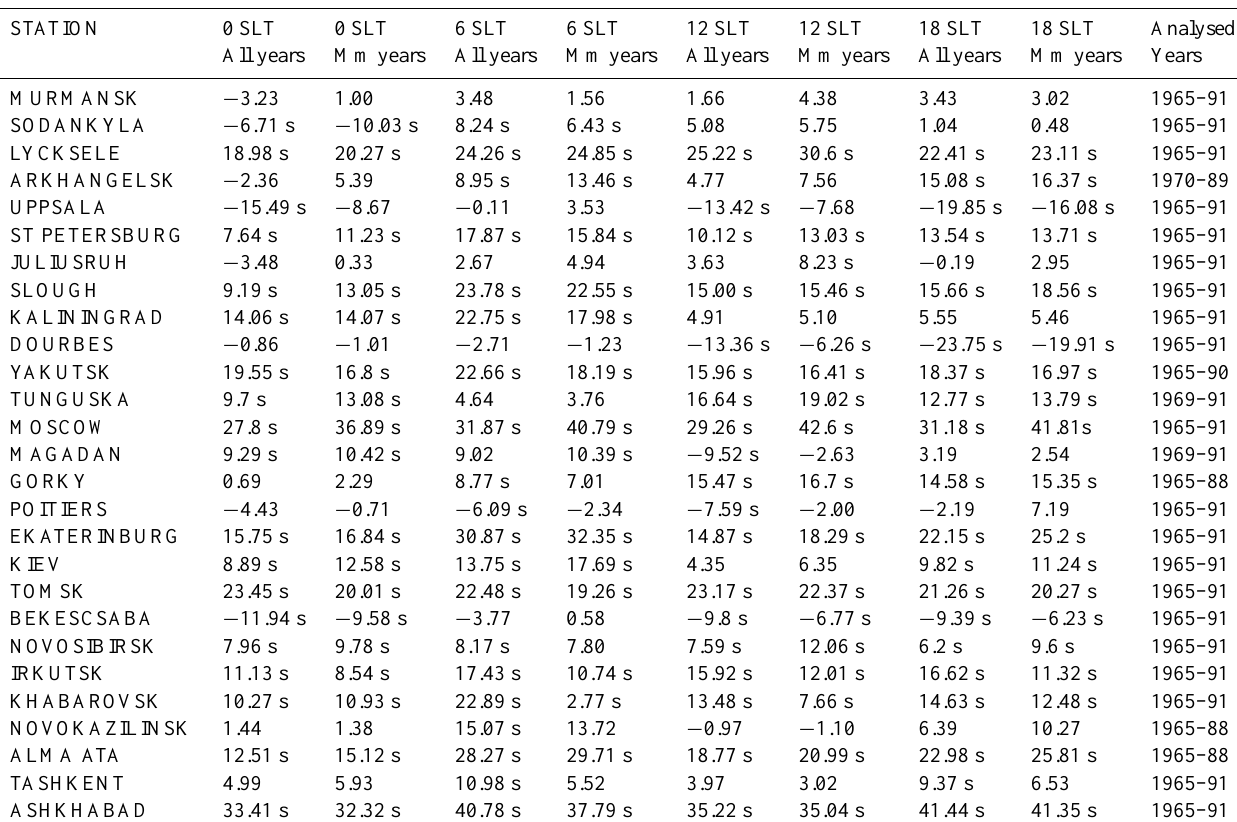
Table 4. Calculated annual mean slope K (in 10–4 units) for the period 1965–1991. Regression of hm F2 with R 12 (Model 1), and all years as well as years around solar maximum and minimum (Mm years) are used to obtain hm F2 linear trends. Significant trends at a confidence level of 95% are denoted by an “s” after the value